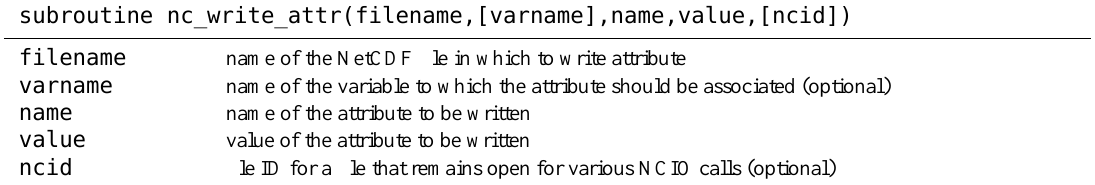
Table A5. Subroutine call and argument descriptions for nc_write_attr .